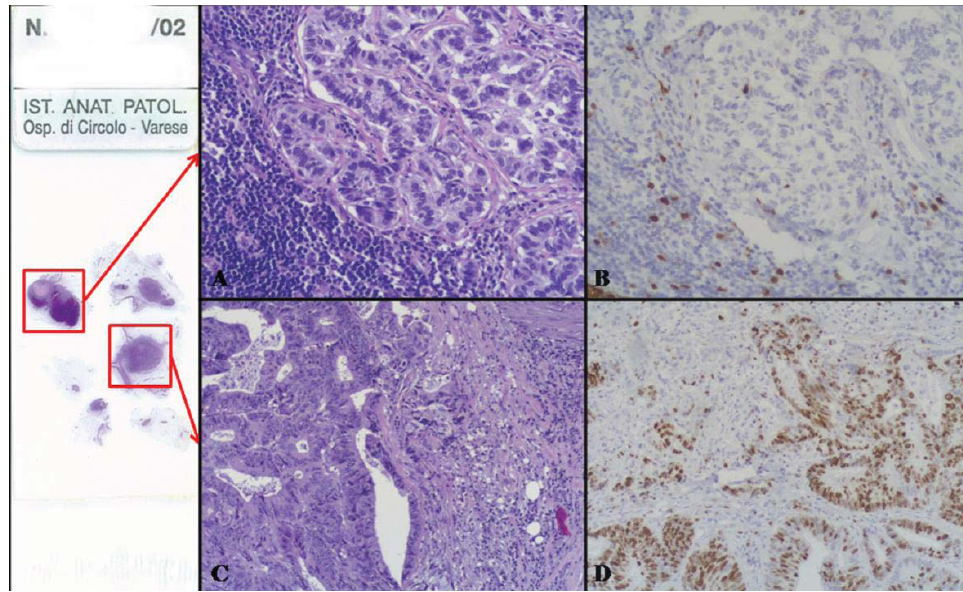
Figure 9. On the left, there is a slide with lymph nodes isolated in the perirectal fat tissues of the tumor shown in Figure 7. In one lymph node there was a metastasis from the NET component ( A ) which shows very low Ki67 index ( B ). In another lymph node the metastasis was from the adenocarcinoma ( C ) which shows a high Ki67 proliferative index ( D